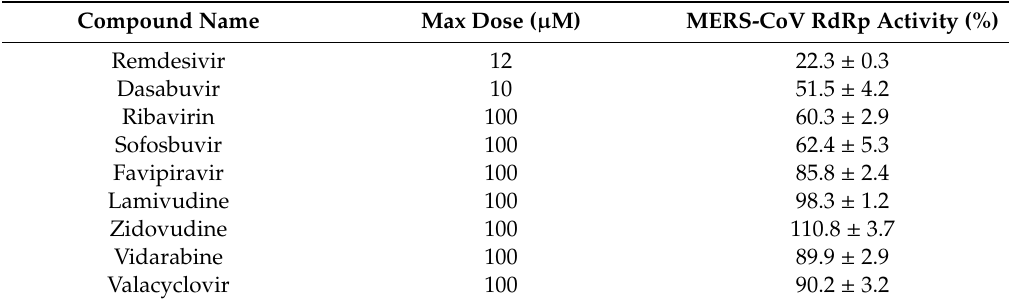
Table1. PercentactivityofMiddleEastrespiratorysyndromecoronavirus(MERS-CoV)RNA-dependent RNA polymerase (RdRp) at the maximum concentrations of the test compounds.